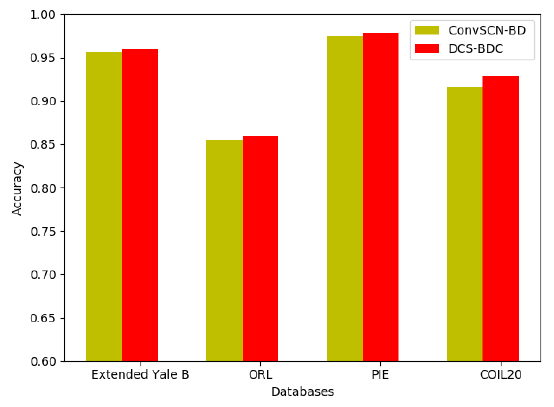
Figure 2. Visualization of the representation matrices based on Extended Yale B, ORL and COIL20. For the convenience of observation, for different database, we multiply the Z by 10, 10 and 100, respectively.